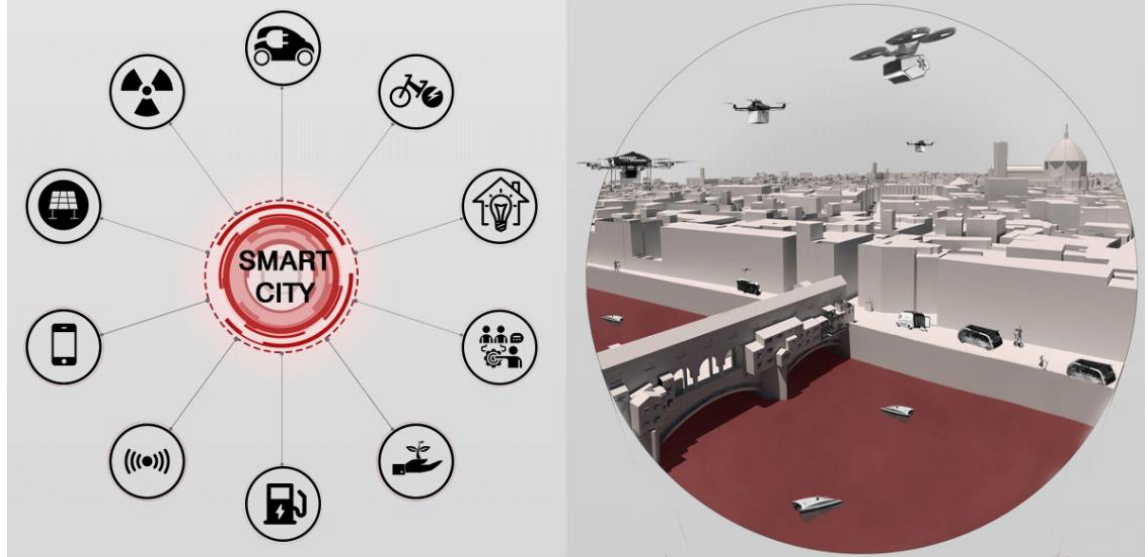
Figure 5 Simone Saporito, Florenze Smart City, Florence School of Architecture,